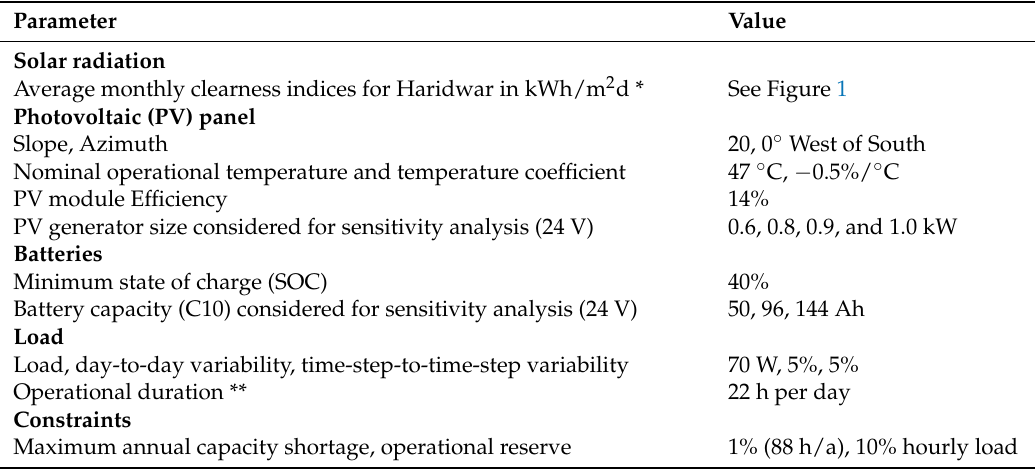
Table 3. Technical parameters for sensitive analysis conducted with Homer.